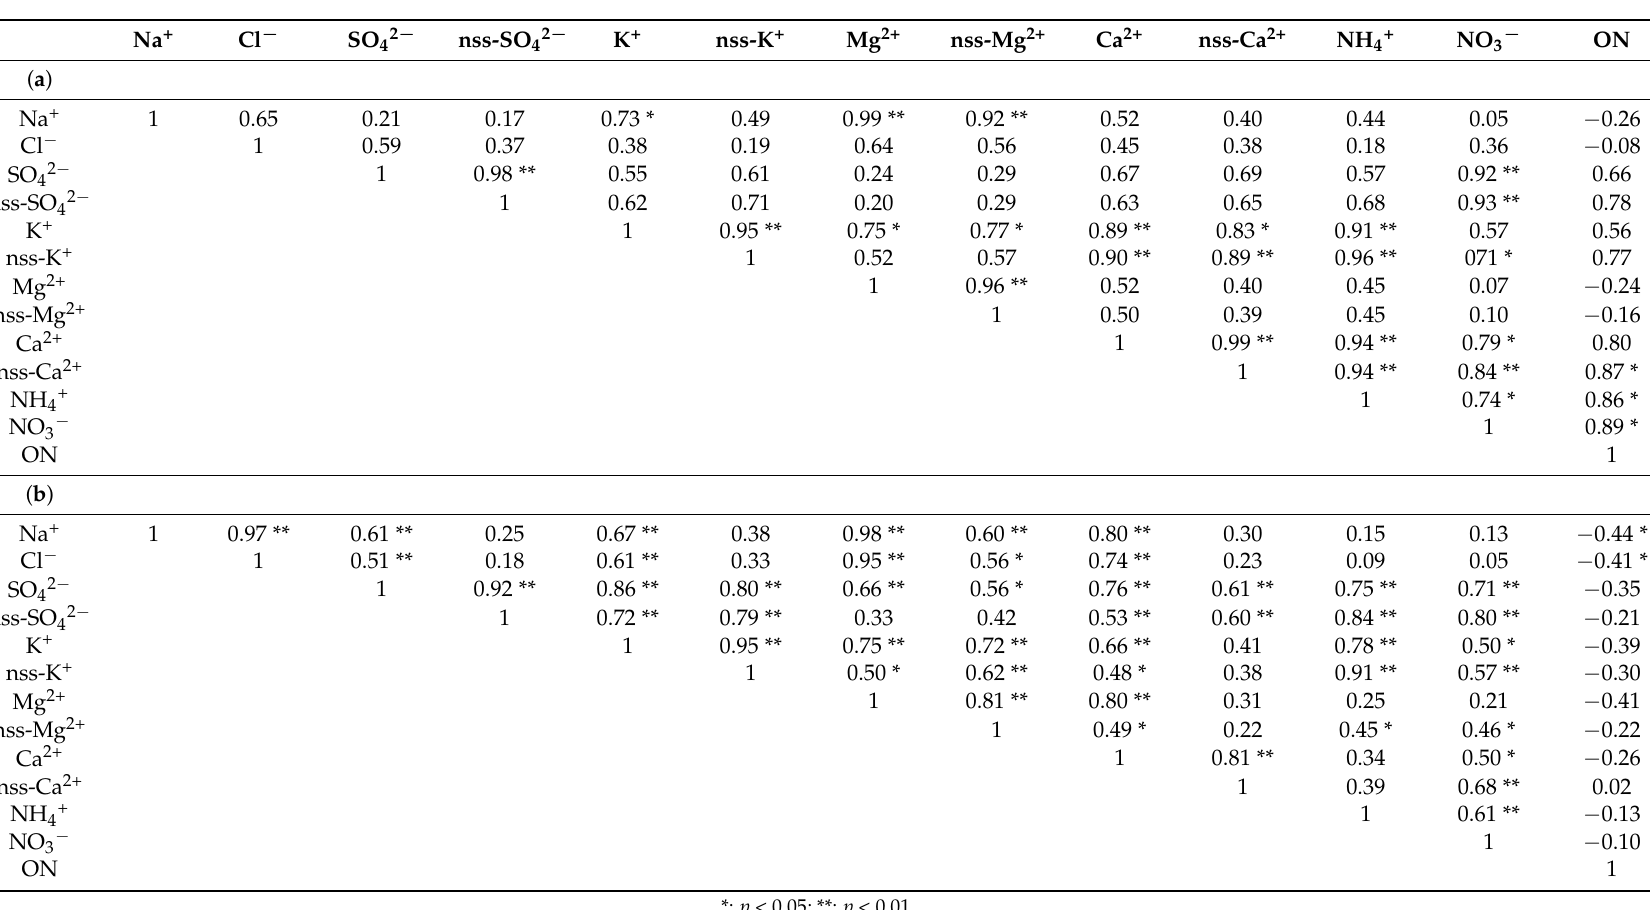
Table 1. Correlation coefficients among major ions in aerosol over the western North Pacific with air masses from continent (( a ), n = 8) and open ocean (( b ), n = 23). Na + Cl − SO 42 − ON ( a ) Na + SO 42 −